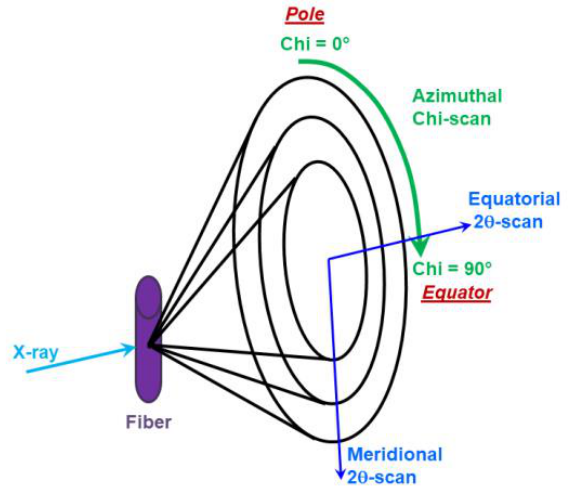
Figure 8. Scheme of the WAXS experiments.